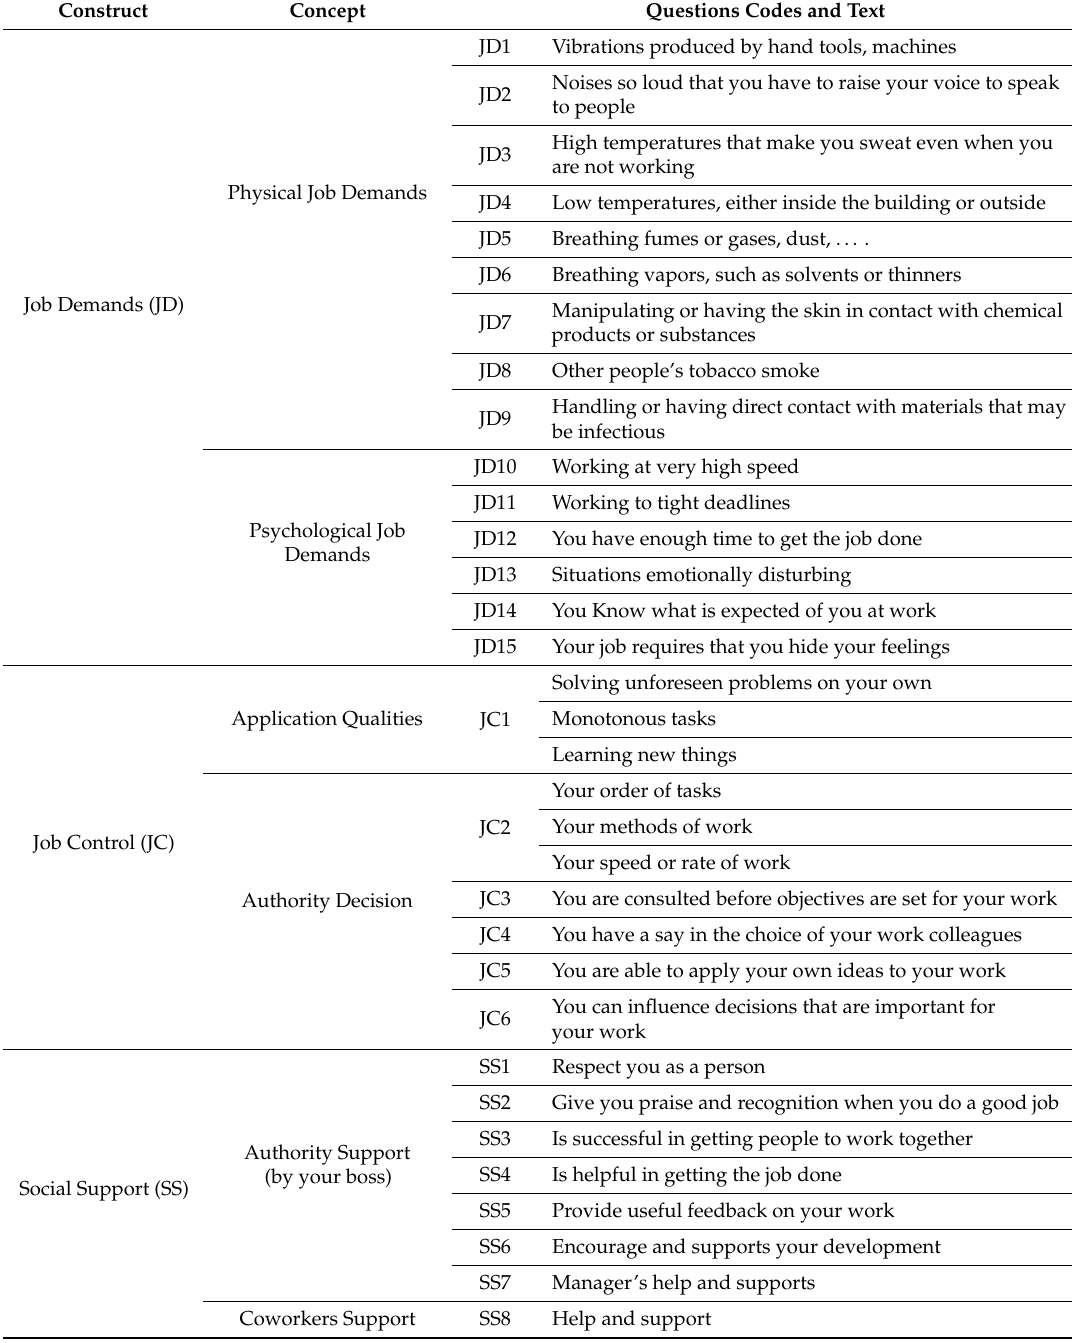
Table 1. European Working Conditions Survey (EWCS) variables linked to exogenous